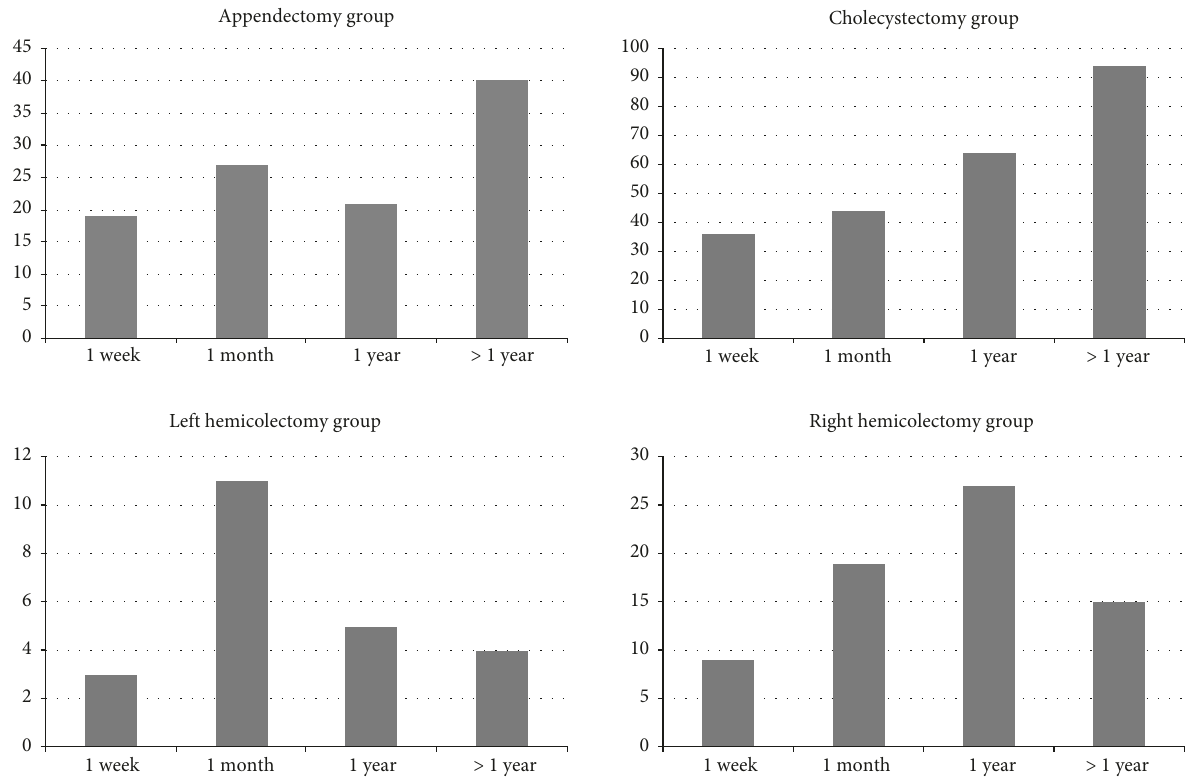
Figure 1: CDAD cases for the 4 groups according to the postoperative period (1 st week, 1 st month, 1 st year, and > 1